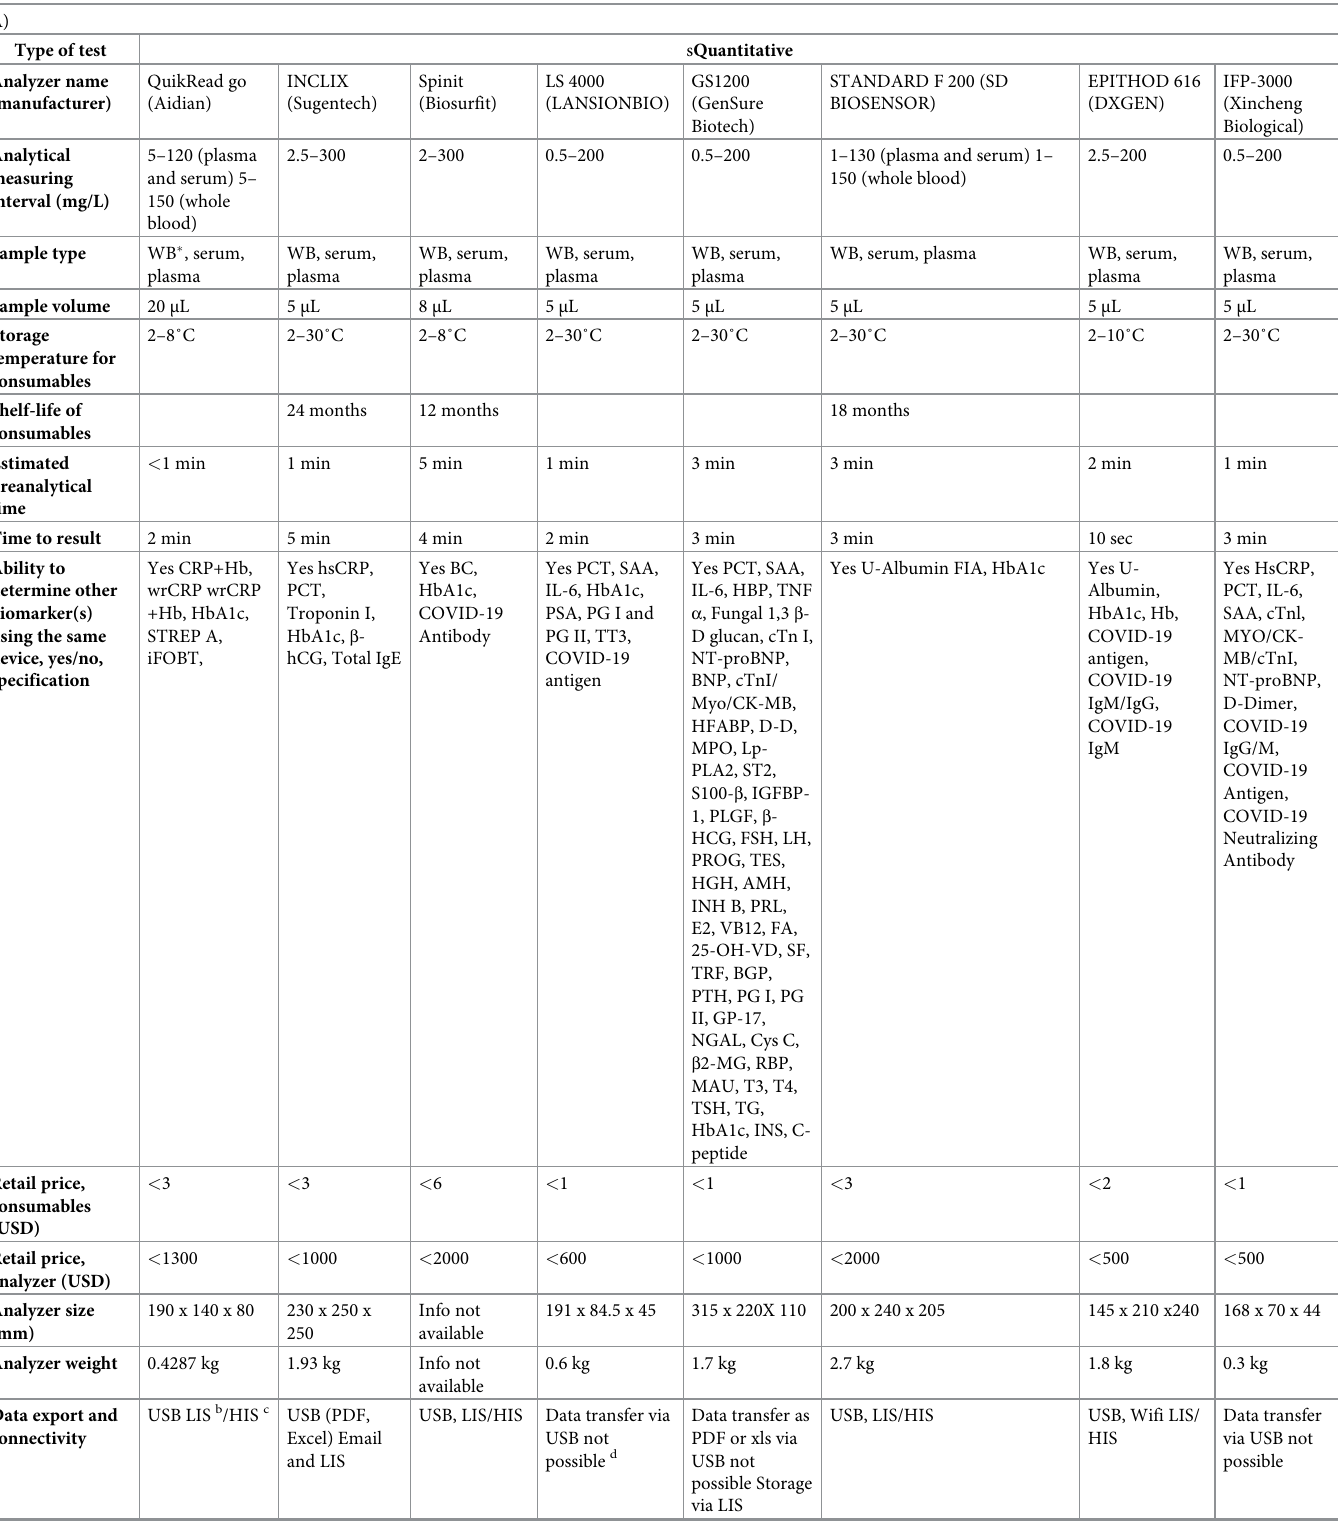
Table 1. Detailed information on evaluated index tests, A) quantitative and B)